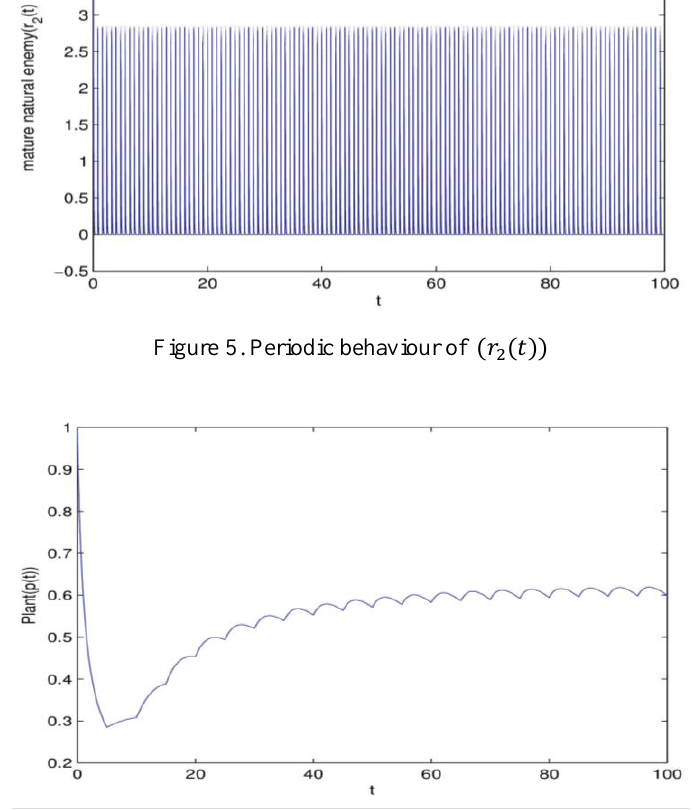
Figure 6. Plant population (𝑝(𝑡)) exists